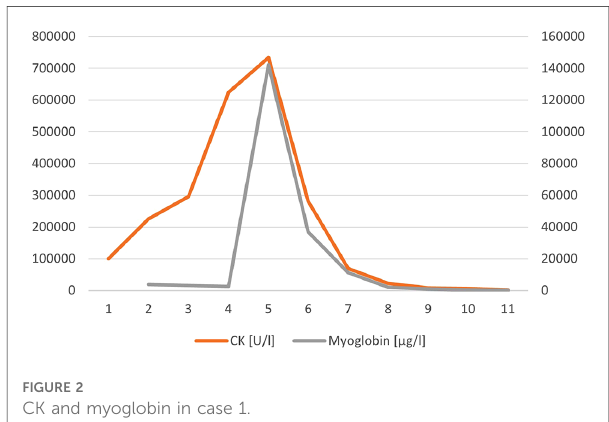
FIGURE 2 CK and myoglobin in case 1.